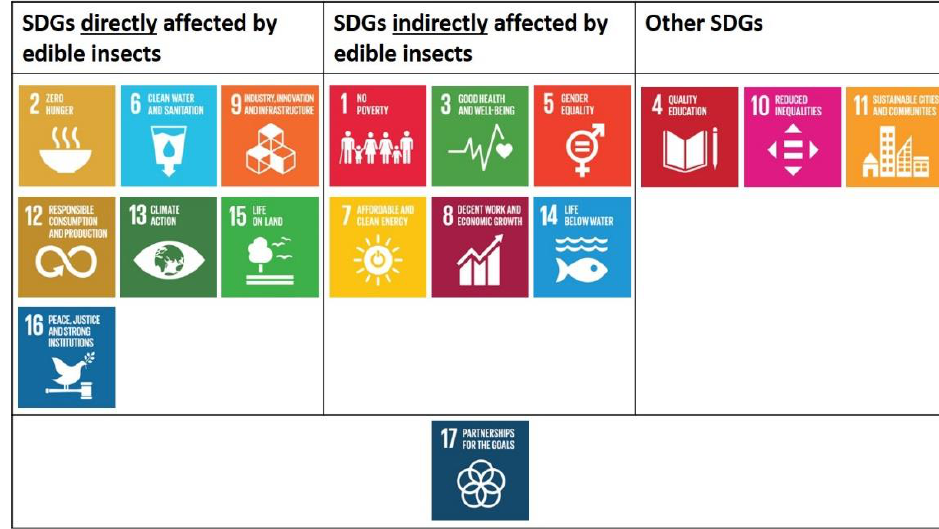
Figure 1. Interaction map between insects and sustainable development